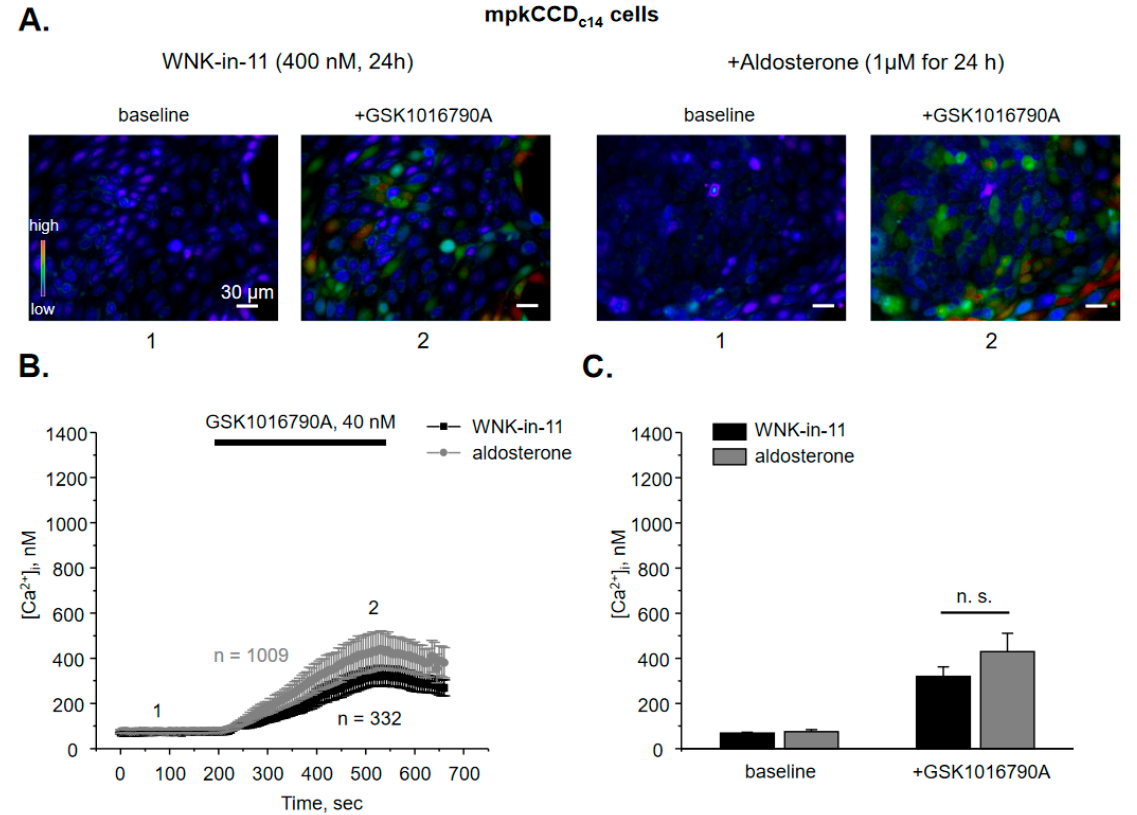
Figure 4. WNK1 is critical for stimulation of TRPV4 activity by aldosterone in mpkCCD c14 cells. ( A ) Representative pseudo- color images of [Ca 2+ ] i changes (blue—low and red—high) in confluent monolayers of mpkCCD c14 cells treated with the selective WNK1 inhibitor WNK-in-11 (400 nM) in the absence and presence of concomitant administration of aldosterone at the baseline (1) and following 5 min application of TRPV4 agonist, GSK1016790A (2). ( B ) The averaged time-courses of [Ca 2+ ] i changes upon application of 40 nM GSK1016790A (shown with the bar on top) in individual WNK-in-11 pretreated cells mpkCCD c14 cells in the absence and presence of aldosterone. The time-points 1 (baseline) and 2 (GSK1016790A) represent conditions shown in panel (A). ( C ) Summary graph comparing [Ca 2+ ] i values in individual WNK-in-11 pretreated mpkCCD c14 cells in the control and following aldosterone treatment at the baseline and after GSK1016790A application. N.s. represents non-significant difference ( p > 0.05).